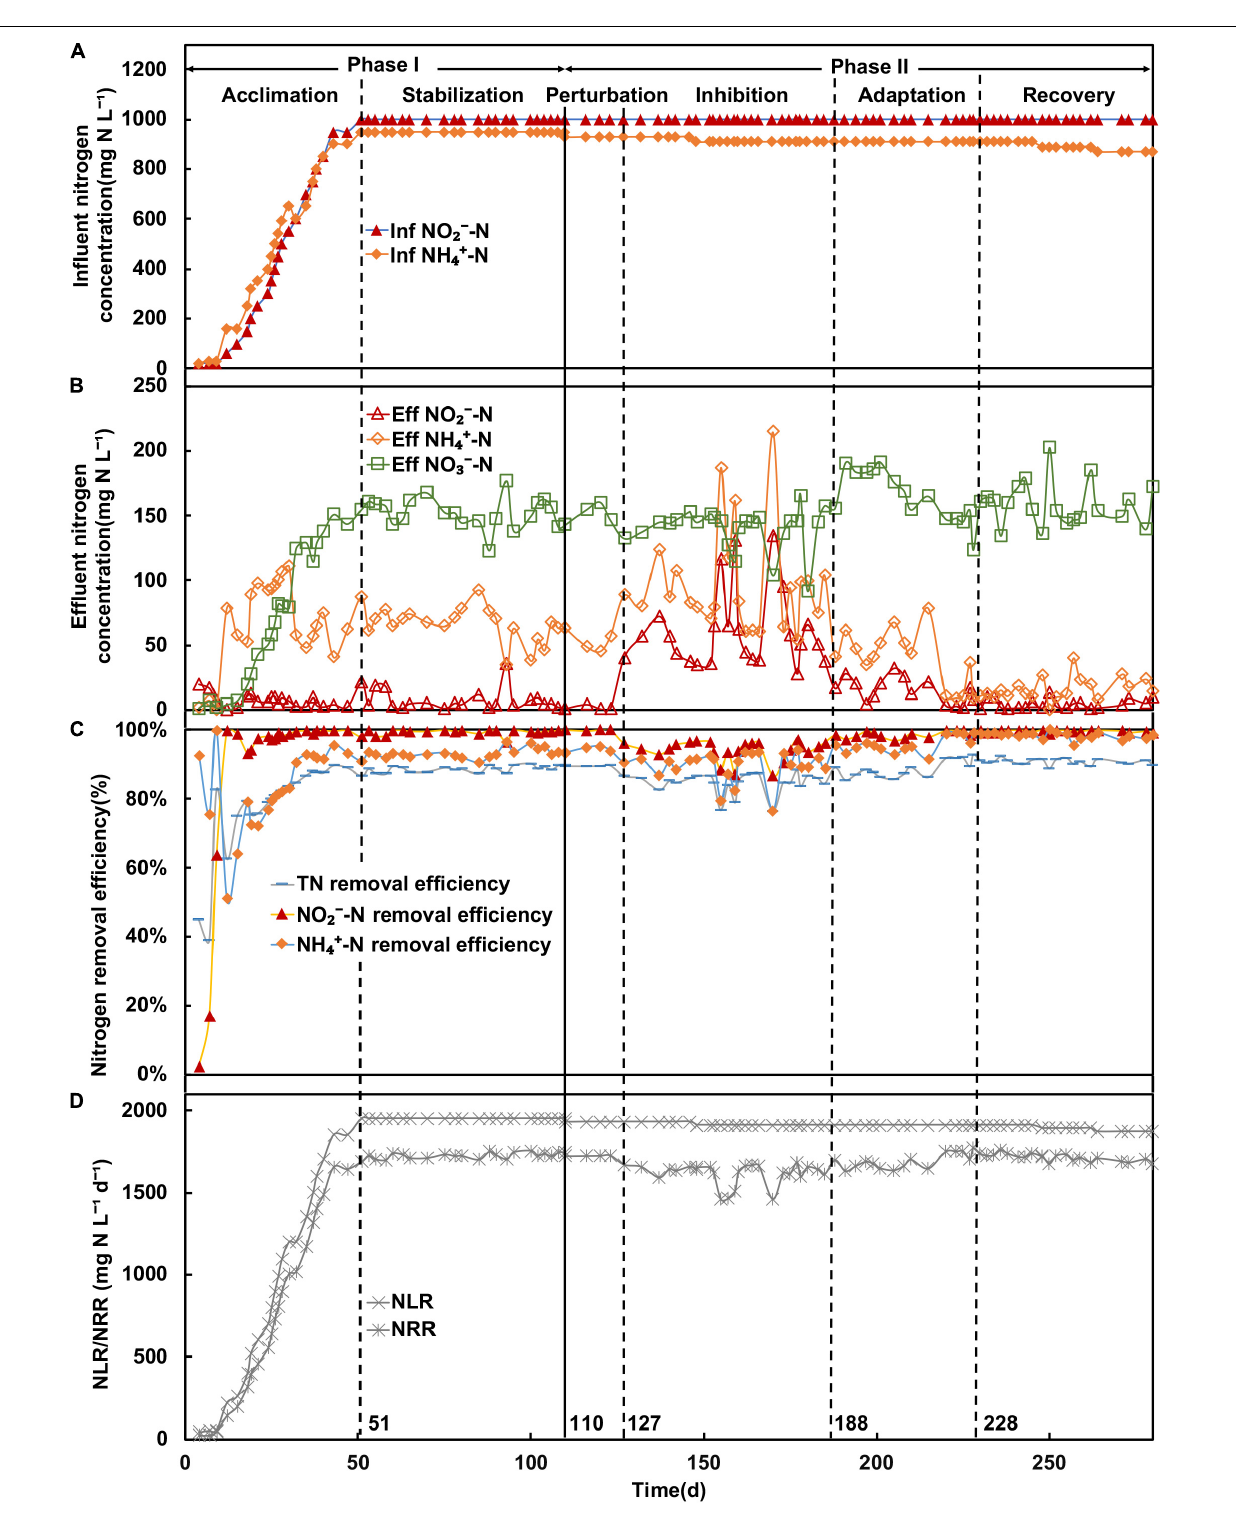
Frontiers in Microbiology |